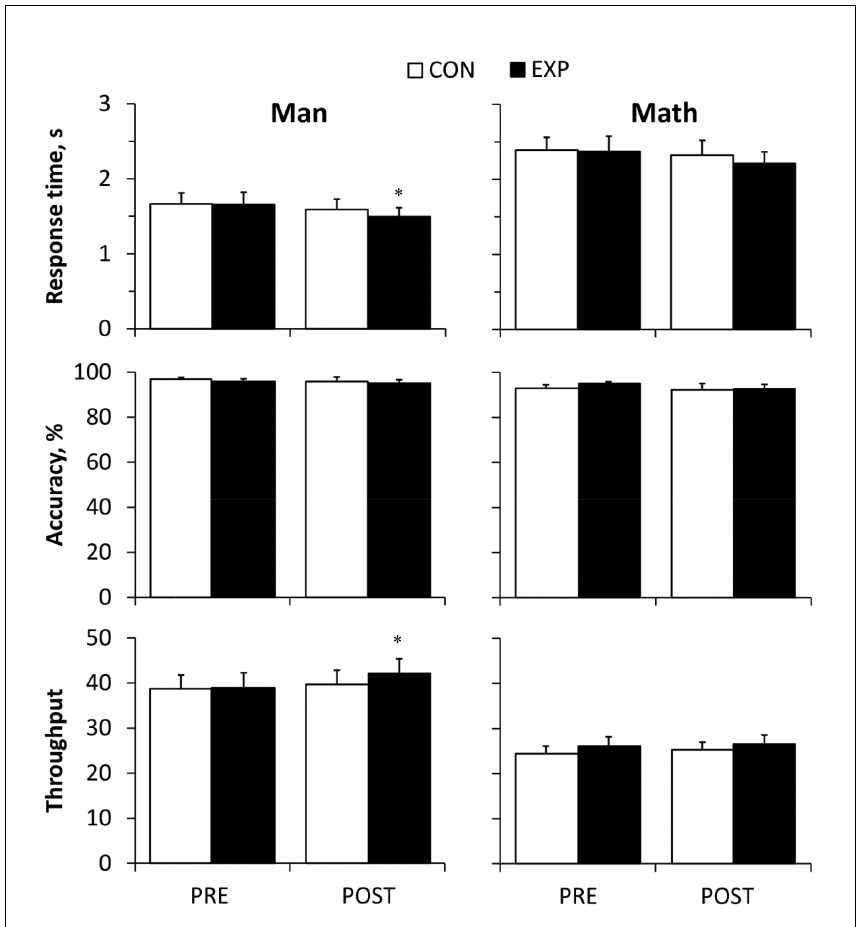
Figure 3. The manikin (Man) and the Mathematical Processing (Math) test mean response